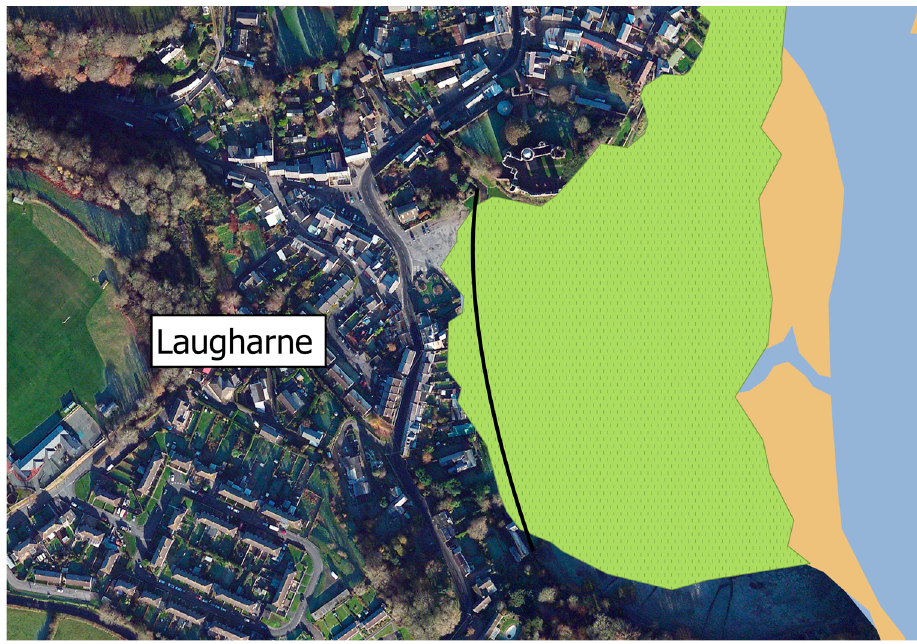
Figure 8. Position of the hard flood defence (shown in black line) protecting the village of Laugharne.